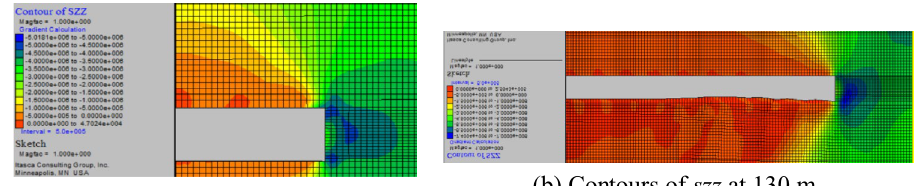
(a) Contours of szz at 30 m